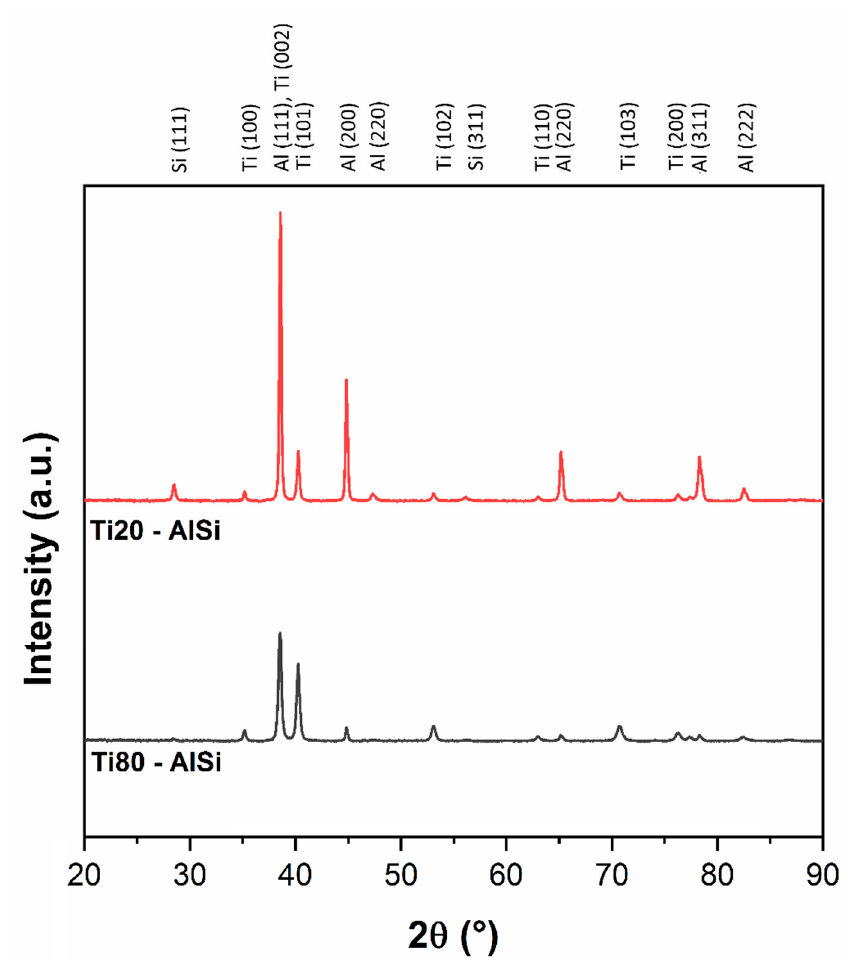
Figure 3. XRD diffraction patterns for the Ti20-AlSi and Ti80-AlSi dense samples.